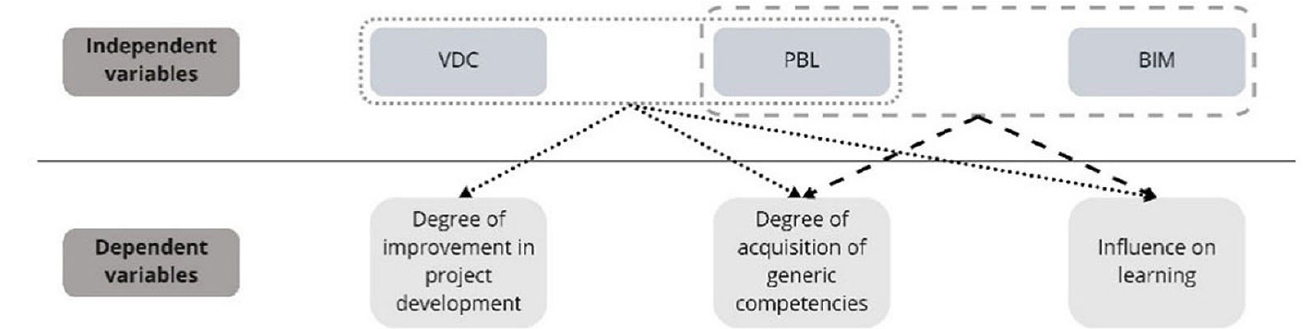
Fig. 1. Relation between independent and dependent